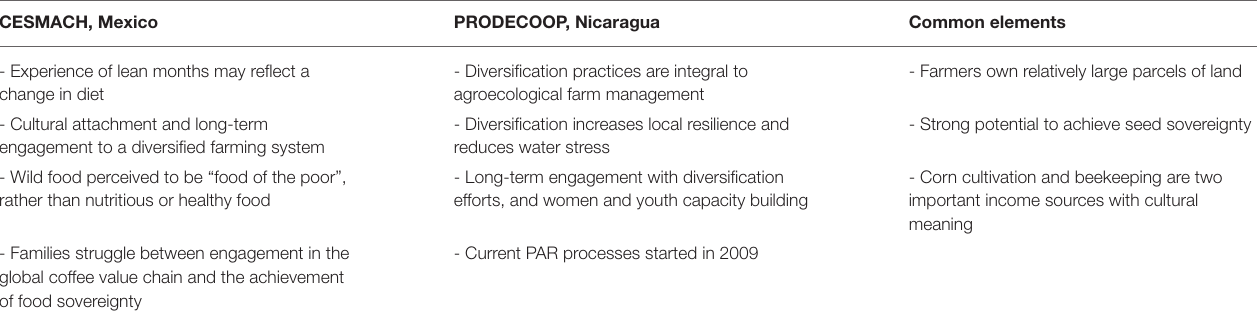
TABLE 3 | Contributions and challenges to food sovereignty due to diversification practices. CESMACH,